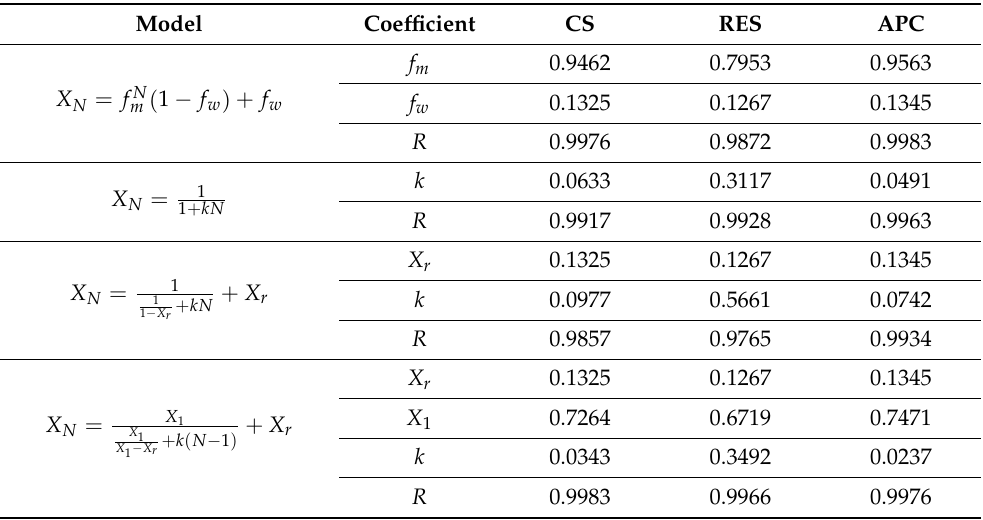
Table 4. Parameter fitting for models of carbonation reactivity